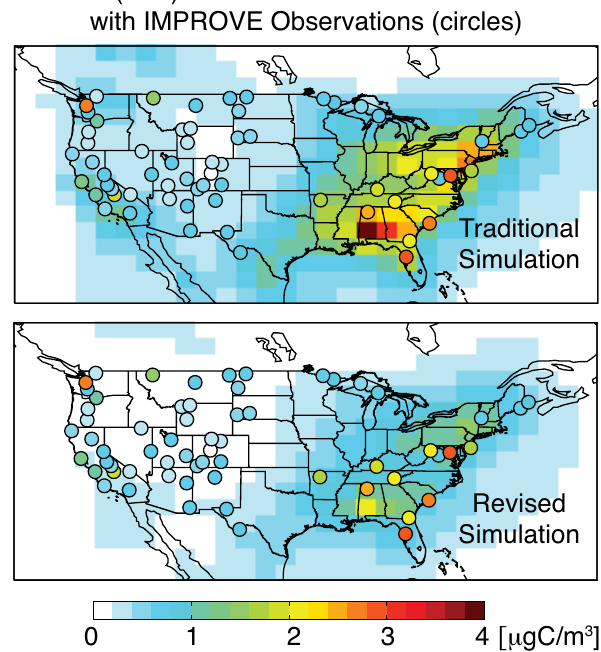
Fig. 7. Winter (December-January-February 2000) surface total OC concentration from 2 ◦ × 2 . 5 ◦ (GEOS-4) simulations for the tradi- tional and revised frameworks. Total OC includes POA and SOA from traditional precursors, IVOCs, and SVOCs. IMPROVE obser- vations (averaged over DJF for year 2000) are overlaid in circles. An outlier value of > 27µgC/m 3 has been removed from the IM- PROVE observations. Only sites with valid data for at least half of the DJF 2000 season are